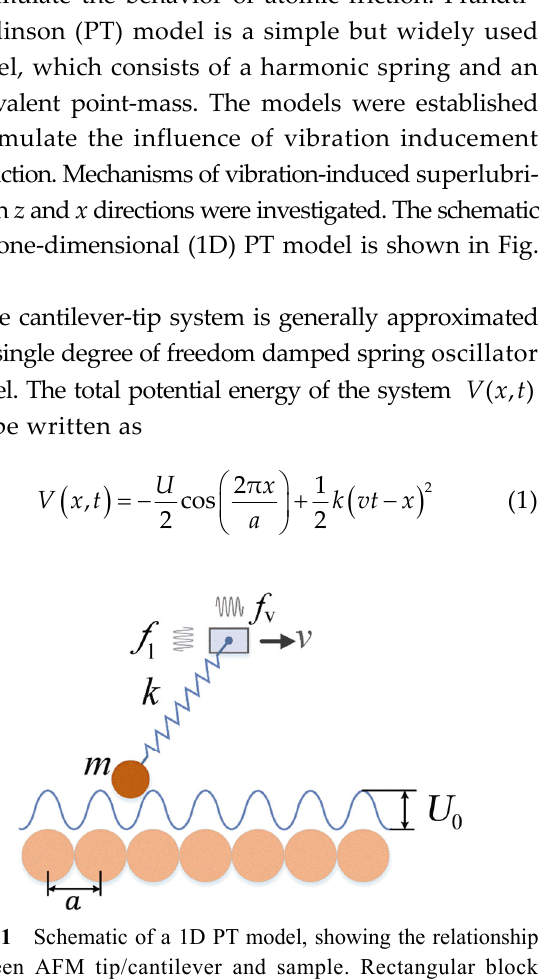
Fig. 10 Friction as a function of the applied normal load for different directional vibrations: (a) z -directional, (b) x -directional, and (c) y -directional vibrations.